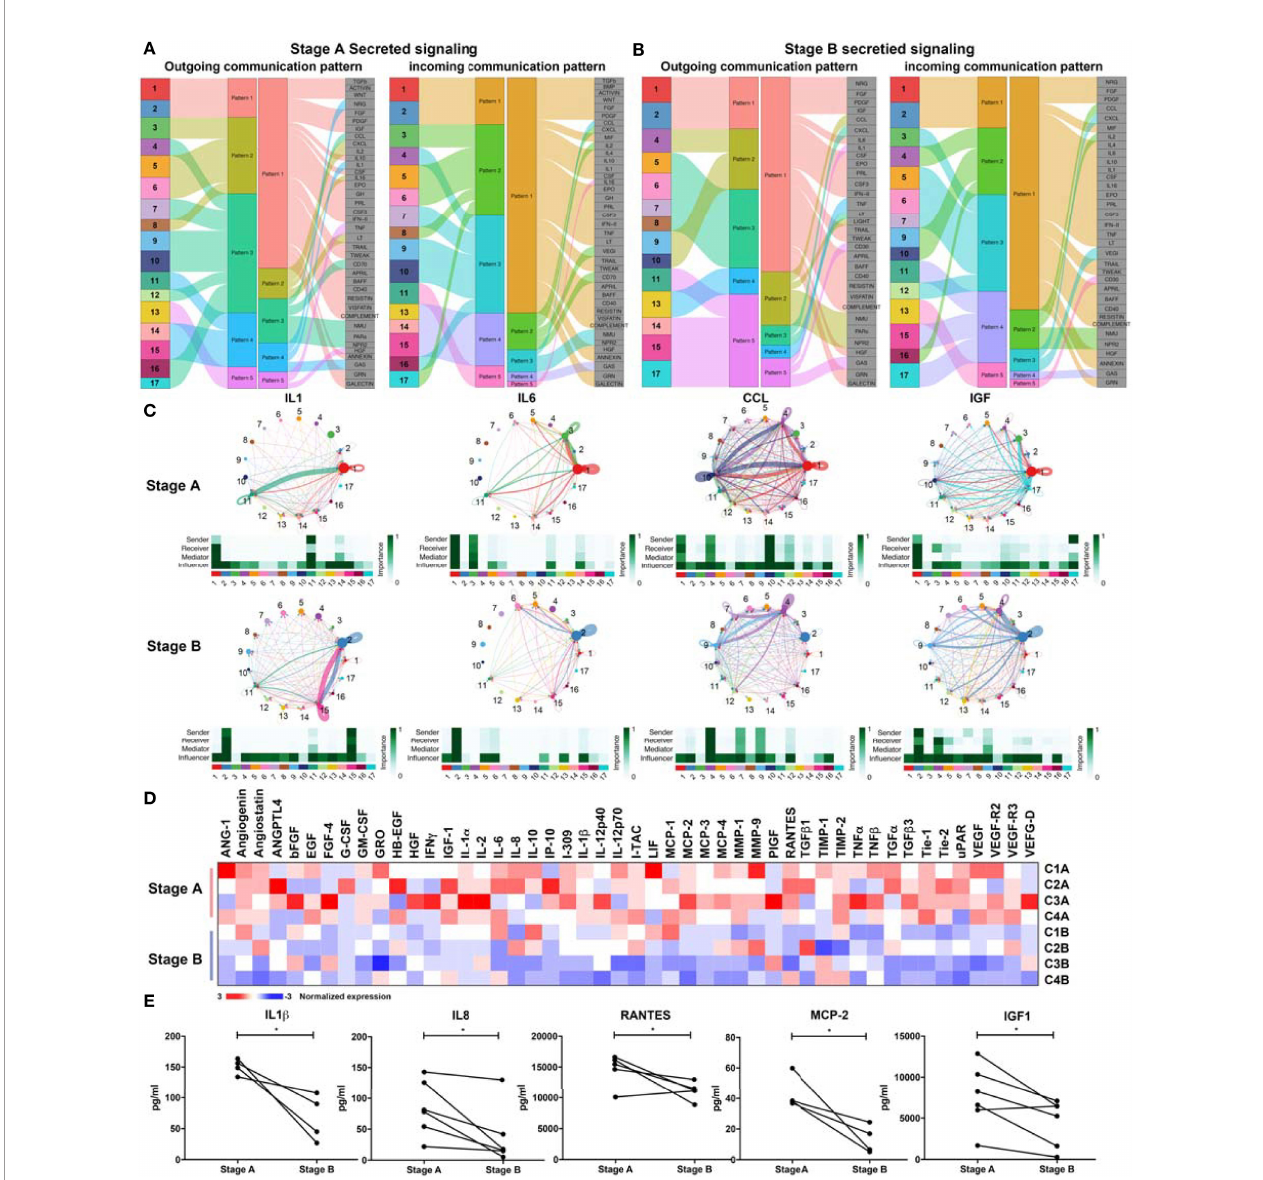
FIGURE 5 | Secreted signaling communications among immune cells. (A) Outgoing and incoming communication patterns of secreted signaling pathways in stage A. In outgoing communication patterns, Clusters 1 – 17 are indicated as different colors and classi fi ed into fi ve patterns (patterns 1 – 5), according to the outgoing signals they shared. Pattern 1 includes Clusters 1 and 2 (CD14 + CD16 - monocytes). Pattern 2 includes Cluster 3 (CD4 + Tm), Cluster 5 (CD4 + Tm), Cluster 6 (XIST + CD4 + T), and Cluster 8 (memory B). Pattern 3 includes Cluster 4 (CD8 + Teff), Cluster 7 (SYNE1 + CD8 + T), Cluster 9 (NK), Cluster 10 (NK), Cluster 12 (CD8 + Teff), Cluster 16 (cycling CD8 + T), and Cluster 17 (plasma cells). Pattern 4 includes Cluster 11 (CD14 + CD16 - monocytes), Cluster 14 (CD14 + CD16 dim monocytes), and Cluster 15 (cDCs). Pattern 5 includes Cluster 13 (CD14 dim CD16 + monocytes). In incoming communication patterns, Clusters 1 – 17 were classi fi ed into fi ve patterns (patterns 1 – 5) except for Cluster 12. Pattern 1 includes Clusters 1 and 2 (CD14 + CD16 - monocytes). Pattern 2 includes Cluster 3 (CD4 + Tm), Cluster 5 (CD4 + Tm), Cluster 6 (XIST + CD4 + T), Cluster 8 (memory B), and Cluster 17 (plasma cells). Pattern 3 includes Cluster 4 (CD8 + Teff), Cluster 7 (SYNE1 + CD8 + T), Cluster 9 (NK), Cluster 10 (NK), and Cluster 16 (cycling CD8 + T). Pattern 4 includes Cluster 13 (CD14 dim CD16 + monocytes), Cluster 14 (CD14 + CD16 dim monocytes), and Cluster 15 (cDCs). Pattern 5 includes Cluster 11 (CD14 + CD16 - monocytes). Signals included in these patterns are indicated in gray boxes. (B) Outgoing and incoming communication patterns of secreted signaling pathways in stage B. Outgoing and incoming communication patterns also clustered to fi ve patterns, respectively. (C) Communication network of secreting signals in stage A and stage B. Signals sent by speci fi c cluster are drawn with the same color indicated in panel (A) Target of signaling pathways are pointed by line arrows. Thickness of lines indicate the degree of the signal. Sender, receiver, mediator, and in fl uencer of speci fi c signals are indicated in individual heatmap. (D) Levels of 48 angiogenic proteins/cytokines/chemokines in stages A and B are generalized and presented in the heatmap. Serum samples from four moderate patients are used and analyzed as shown. The normalized expression is scaled from − 3 to 3. (E) Speci fi c in fl ammatory factors (IL1 b , IL8, RANTES, MCP-2, and IGF1) were signi fi cantly decreased in stage B (n = 6 in IGF1, IL8, RANTES; n = 4 in MCP2, IL1 b , IP-10). Paired t-test was performed, and signi fi cances were inferred as p < 0.05